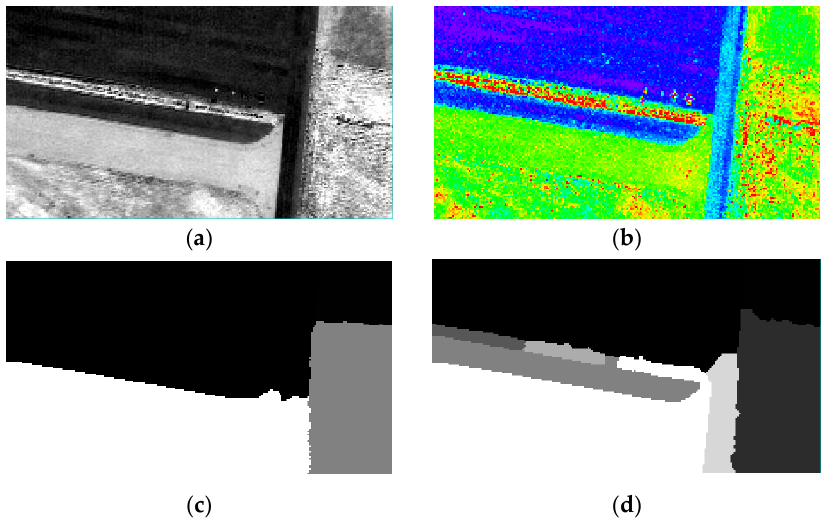
Figure 3. The infrared hyperspectral image and the segmentation results. ( a ) Longwave infrared (LWIR) hyperspectral image; ( b ) temperature image; ( c ) segmentation without temperature; and ( d ) segmentation with temperature.